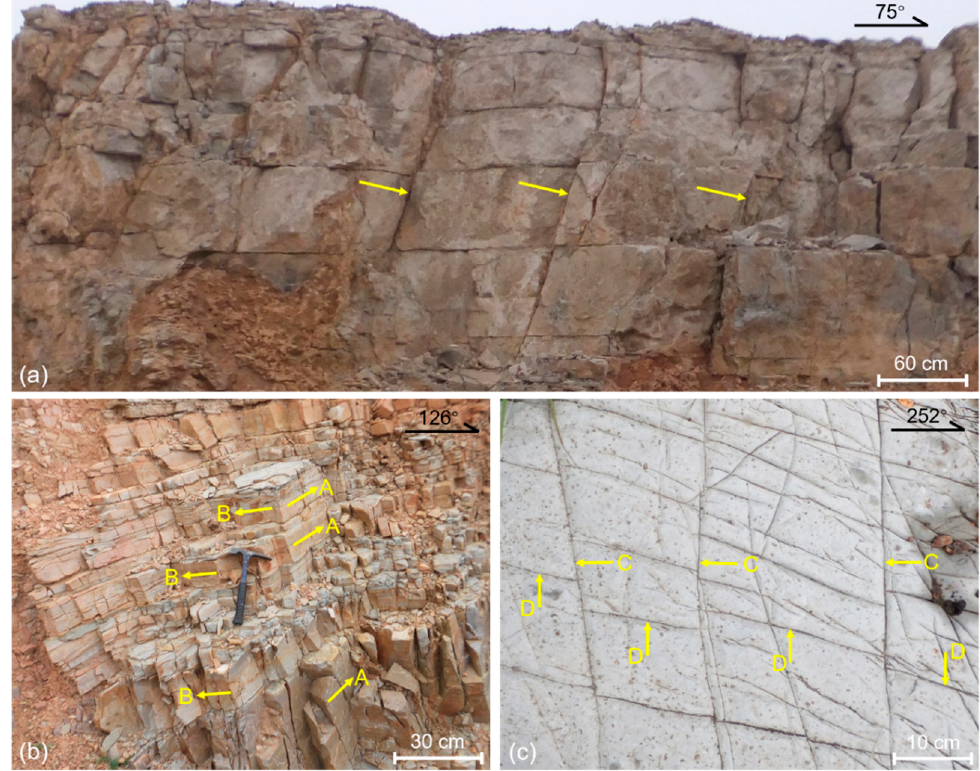
Figure 4. Tectonic fractures in outcrops. ( a ) Fractures are developed with a height of several meters on the cross-section. ( b ) Fractures are developed within the rock formation with a height of a few tens of centimeters. ( c ) Fractures show mutual crosscutting relations on the horizontal plane where Set C arrests Set D.